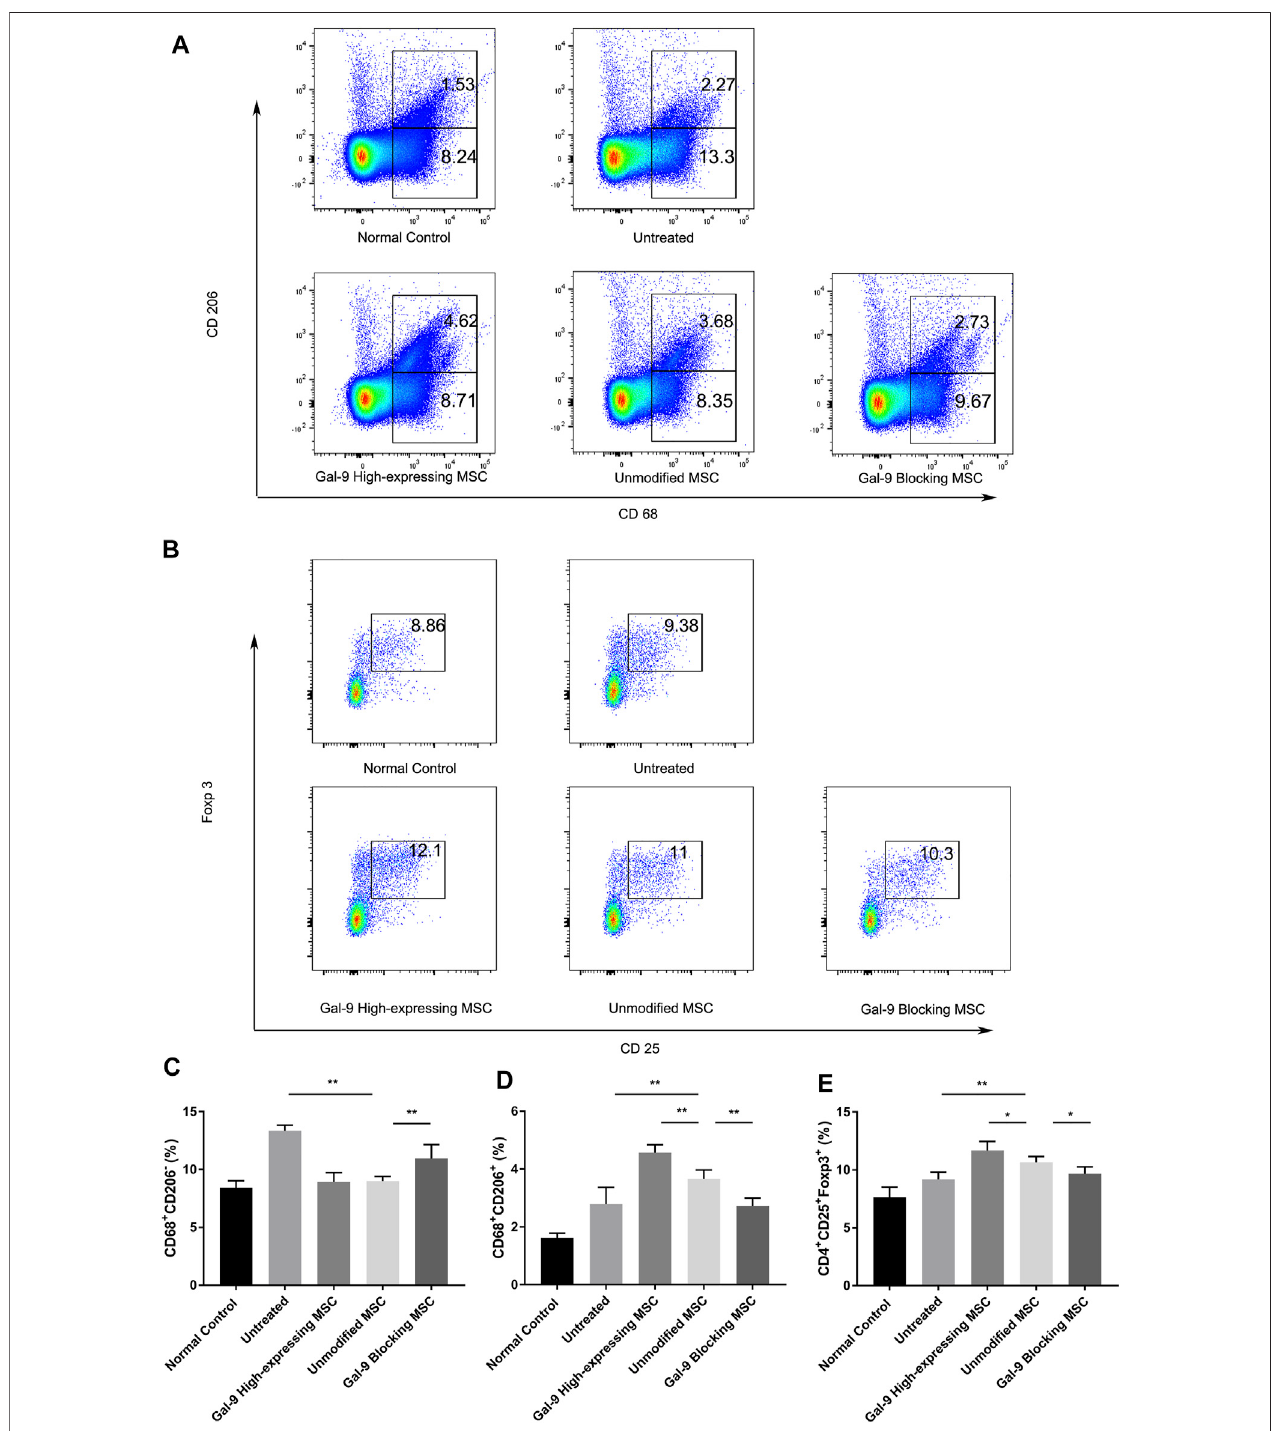
FIGURE 3 | Gal-9 mediates MSC-based therapy in regulation of macrophage polarization and Tregs percentage. Spleen cells were collected 24 h after LPS injection, followed by staining with anti-mouse CD68 antibody for total macrophage, CD68 + CD206 + for M2-type macrophage, and CD4 + CD25 + Foxp3 + for Tregs. (A) RepresentativedotplotsofM1(CD68 + CD206 − )andM2(CD68 + CD206 + )macrophage. (B) RepresentativedotplotsofTreg(CD4 + CD25 + Foxp3 + ). (C) PercentageofM1 (CD68 + CD206 − ) macrophage. (D) Percentage ofM2 (CD68 + CD206 + ) macrophage. (E) Percentage ofTregs in spleen. Data variance was assessed by using one- way analysis of variance (ANOVA), followed by least signi fi cant difference (LSD) test, n = 6. * p < 0.05, ** p < 0.01. Abbreviations: Treg, regulatory T cells; M total, total macrophage.